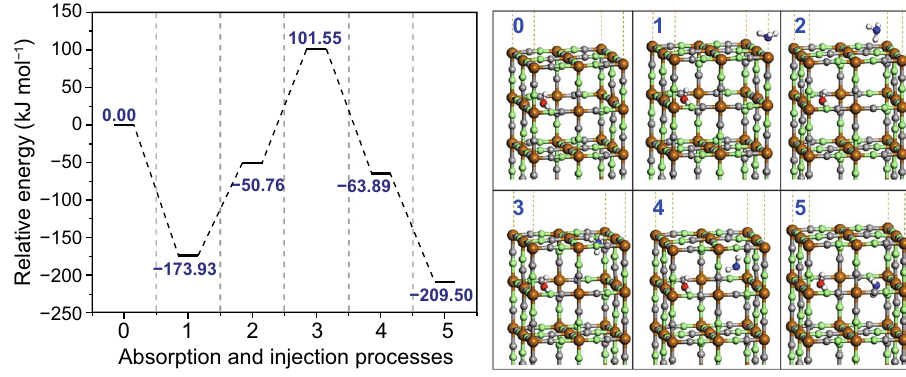
Fig. 4 Absorption and insertion processes of ammonia molecule onto surface and into lattice of BG